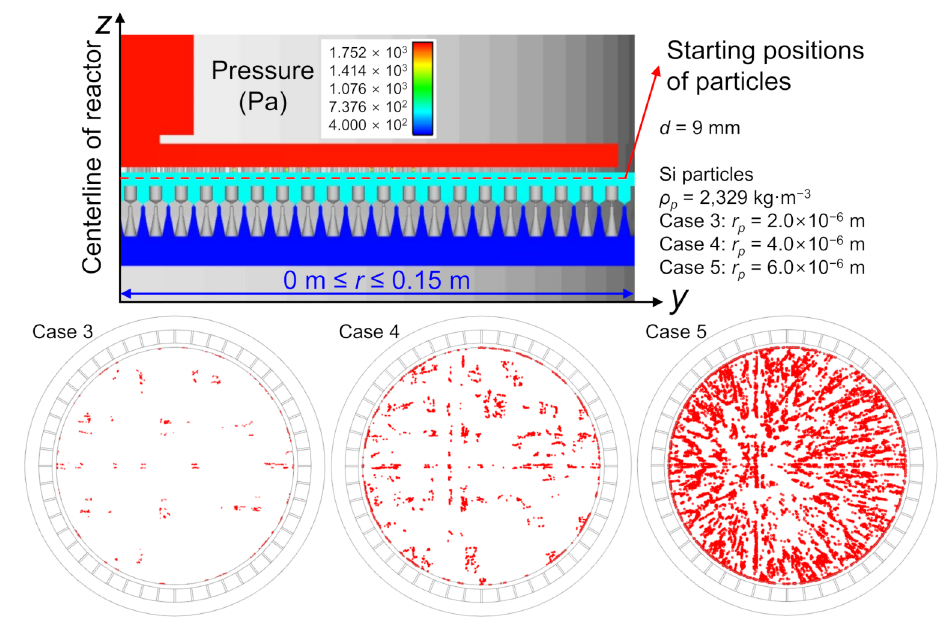
Figure 4. Starting positions of inertial particles are indicated. The spatial variation in the gas pressure ( p g , Pa) is plotted together for Case 3. Final positions of particles deposited on the heater surface depicted for Case 3 ( r p = 2.0 × 10 − 6 m, ρ p = 2329 kg · m − 3 , d = 9 mm), Case 4 ( r p = 4.0 × 10 − 6 m, ρ p = 2329 kg · m − 3 , d = 9 mm), and Case 5 ( r p = 6.0 × 10 − 6 m, ρ p = 2329 kg · m − 3 , d = 9